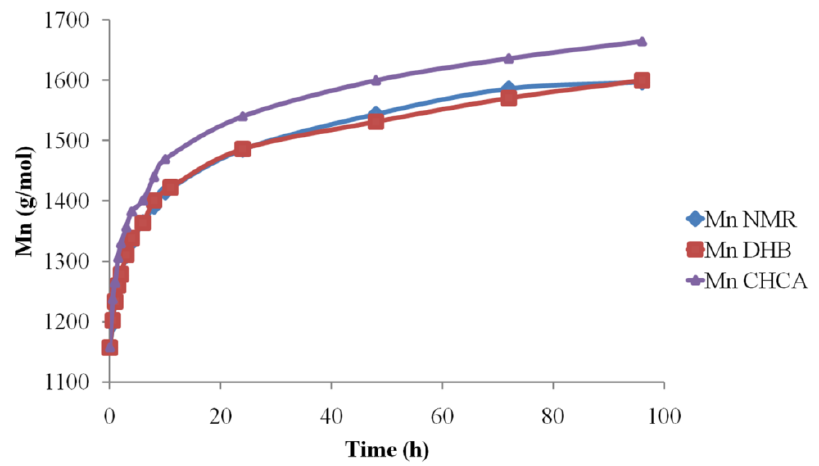
Figure 6. M n evolution determined by MALDI MS and 1 H NMR for #2 .